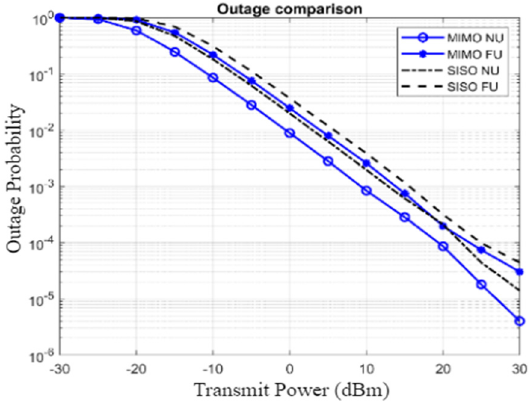
Figure 7. OP vs. transmit power.